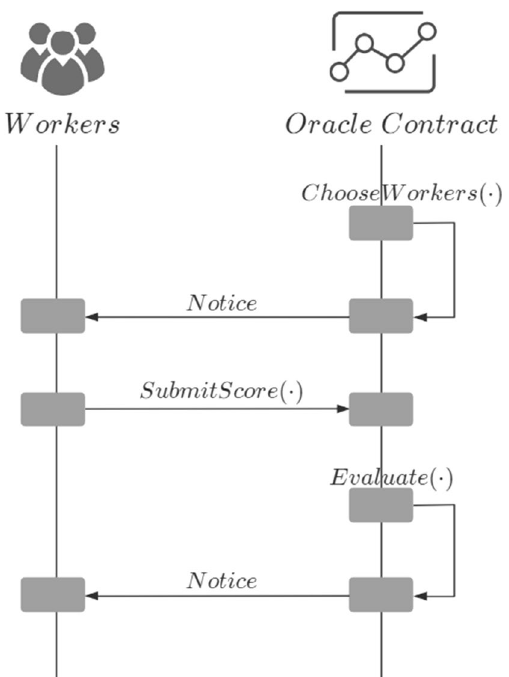
Fig. 7 Task quality evaluation